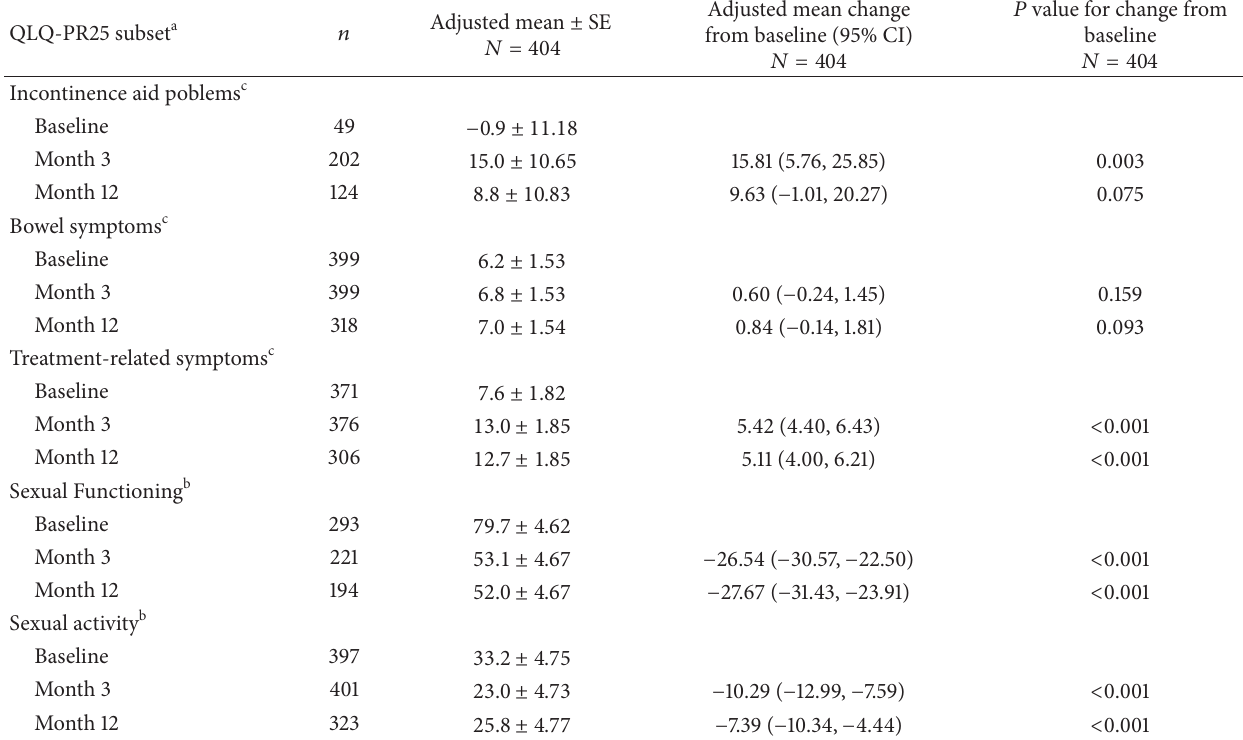
Table 3: Change from Baseline in other QLQ-PR25 Subscale Scores (FAS Population, Observed